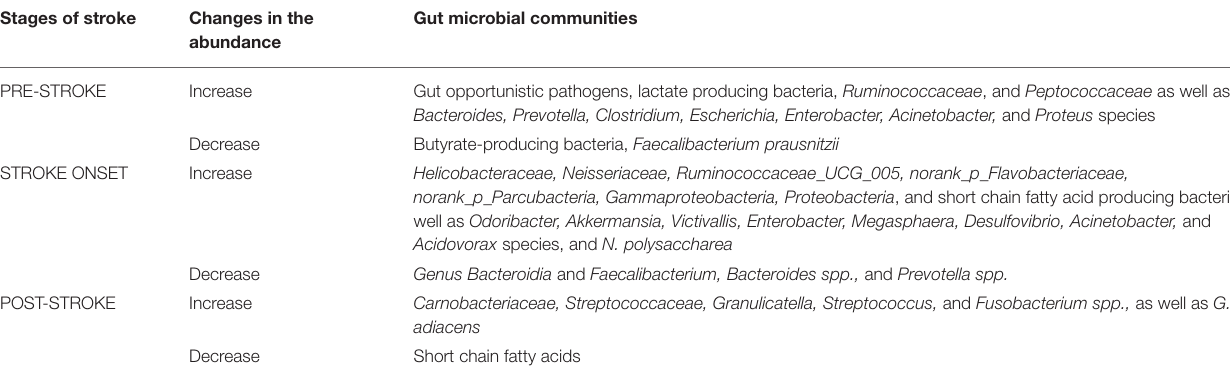
TABLE 2 | Gut microbial communities and their relative abundance change before stroke, during stroke, and after stroke